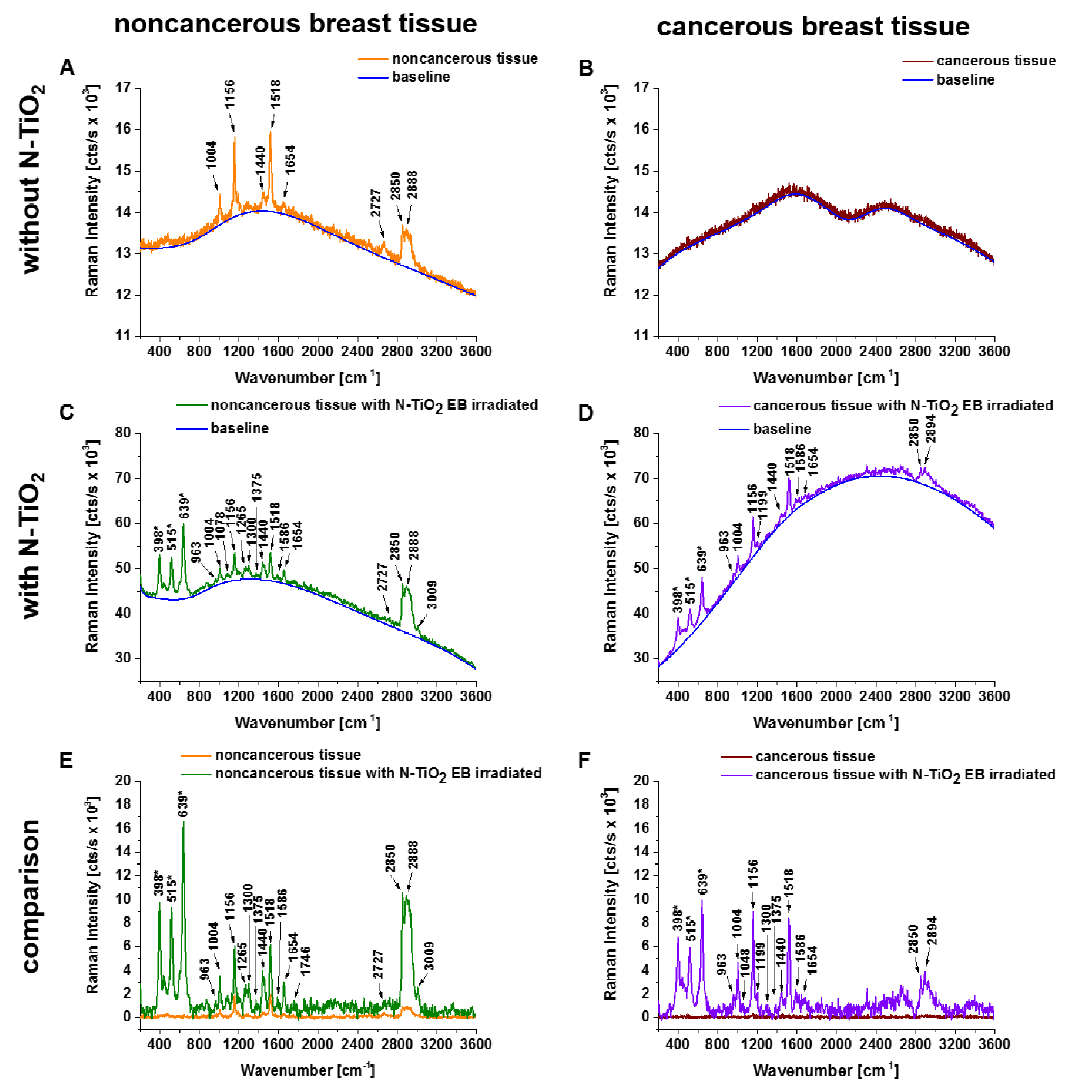
Figure 2. Raman spectra of infiltrating ductal carcinoma (bulk tissue) with and without the addition of N-doped TiO 2 (N:Ti = 1:1) nanoparticles electron beam-irradiated with a dose of 500 kGy. Subsets ( E ) and ( F ) show a comparison of Raman spectra after background subtraction marked in blue lines on raw Raman spectra ( A – D ). Raman bands attributed to N-doped TiO 2 electron beam (EB)-irradiated nanoparticles (NPs) are marked with an asterisk (*).